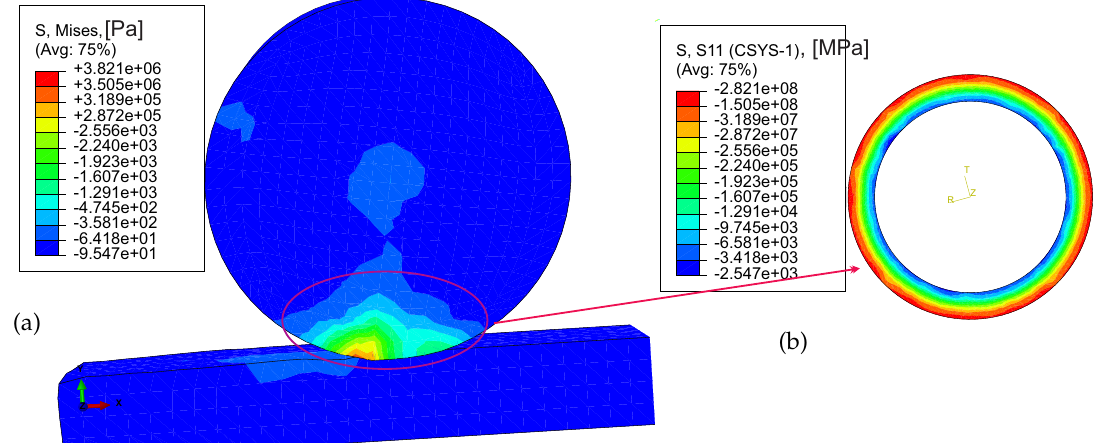
Figure 15. Rolling contact stress field under rolling gap results from ABAQUS. (a) von Mises stress distribution under rolling gap (Increment=1 x 10), (b) Sub-model of radial stress distribution on the rolling die surface (Increment=1 x 10 4 ).